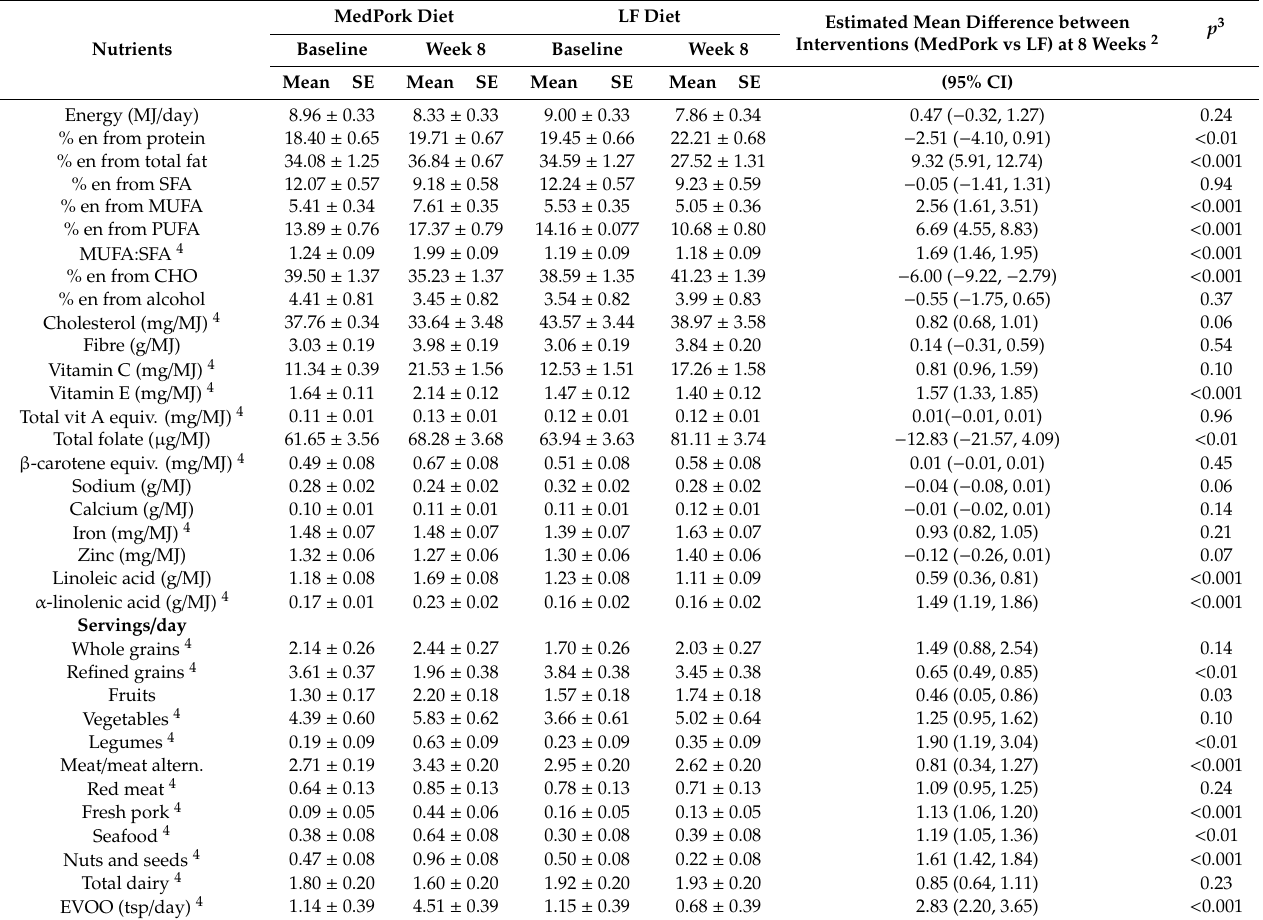
Table 2. Energy and nutrient intakes at baseline and week 8, including between group di ff erences ( n = 33) 1.